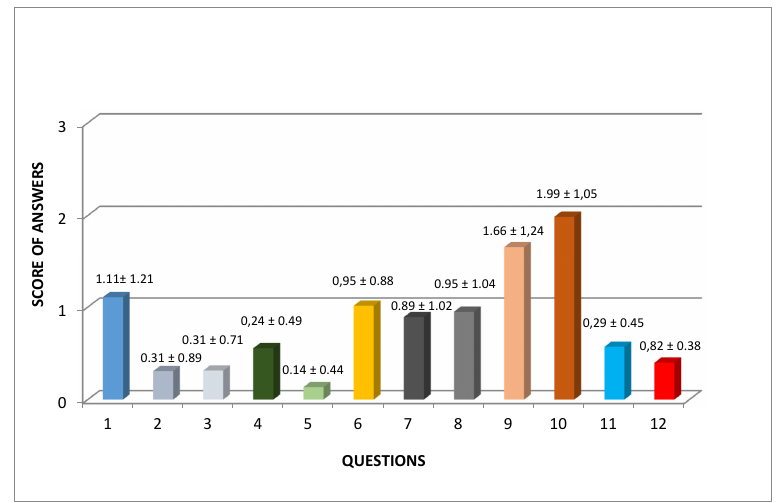
Figure 1. Average scores for each single question of the PPOPS and standard deviation for single questions are reported on each column of the table.